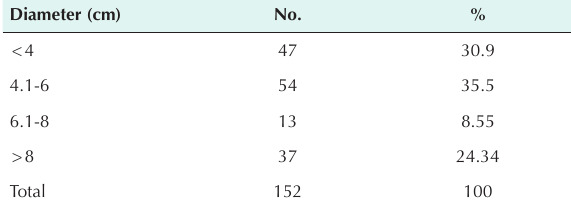
Table 4. Size of Fibroid